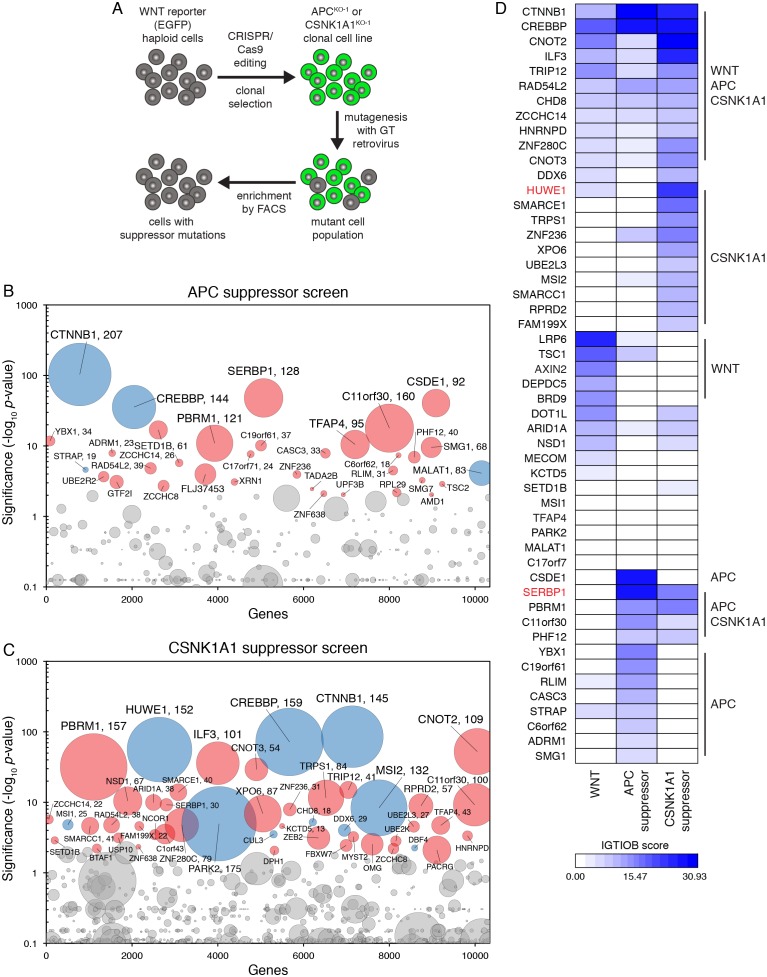
Suppressor screens in cells lacking APC or CSNK1A1 reveal genotype-specific signaling requirements.(A) Schematic of WNT reporter-based suppressor screens. APC or CSNK1A1 was disrupted by CRISPR/Cas9-mediated genome editing of the WNT reporter haploid cell line HAP1-7TGP. Individual clonal cell lines were isolated (APCKO-1 and CSNK1A1KO-1, Supplementary file 2) and mutagenized using GT retrovirus. Cells with reduced reporter activity were enriched by FACS to identify suppressor mutations. (B–C) Circle plots depicting genes enriched for GT insertions in suppressor screens in which constitutive WNT signaling was induced by loss of APC (B) or CSNK1A1 (C). See legend to Figure 1C–1F for details. (D) Heat map comparing the WNT positive regulator, low stringency screen (Figure 1E), and the APC and CSNK1A1 suppressor screens (Figure 5B and C). Genes enriched for GT insertions (FDR-corrected p-value<10−4﻿) in at least one of the three screens were clustered based on their IGTIOB score in each screen (see Materials and methods and Supplementary file 3). Classes of genes preferentially enriched for GT insertions in various screens are indicated. Genes selected for a detailed analysis are labeled in red.